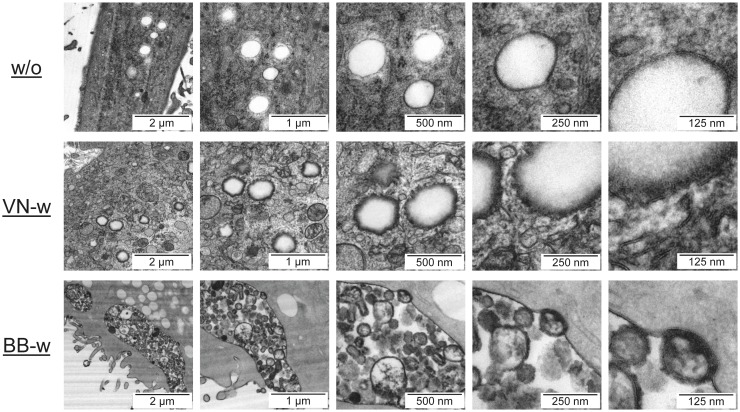
Endolysosomal escape of whole virus vaccine material.Immature DC were incubated for 2(w/o) or with whole virus vaccines of pandemic-like avian strain A/H5N1-Vietnam (VNw) or seasonal strain B/Brisbane (BBw). Subsequently, samples were processed and analyzed by TEM using a Zeiss 912 Omega microscope operated at 120 kV. Pictures were taken at 5 increasing magnifications to allow better detection and tracking of virus material.